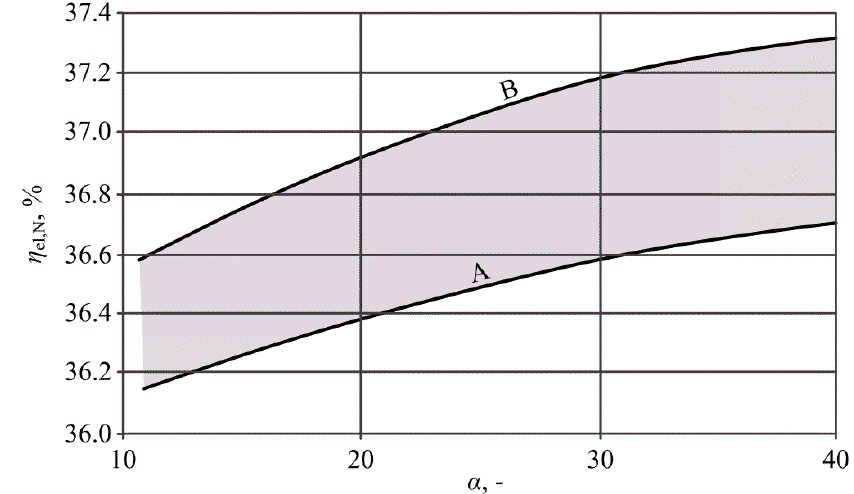
Figure 11. Variant V2 power plant net efficiency as a function of the O 2 /N 2 membrane selectivity coefficient for Variant V2.